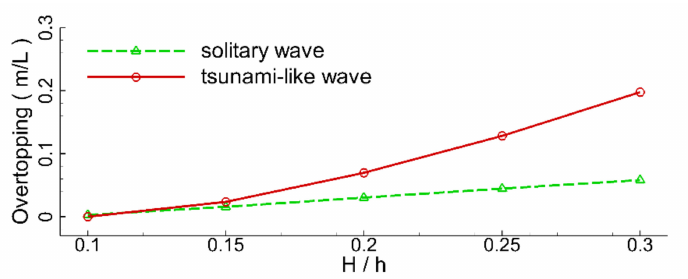
Figure 18. Comparison of the time series of overtopping water with wave